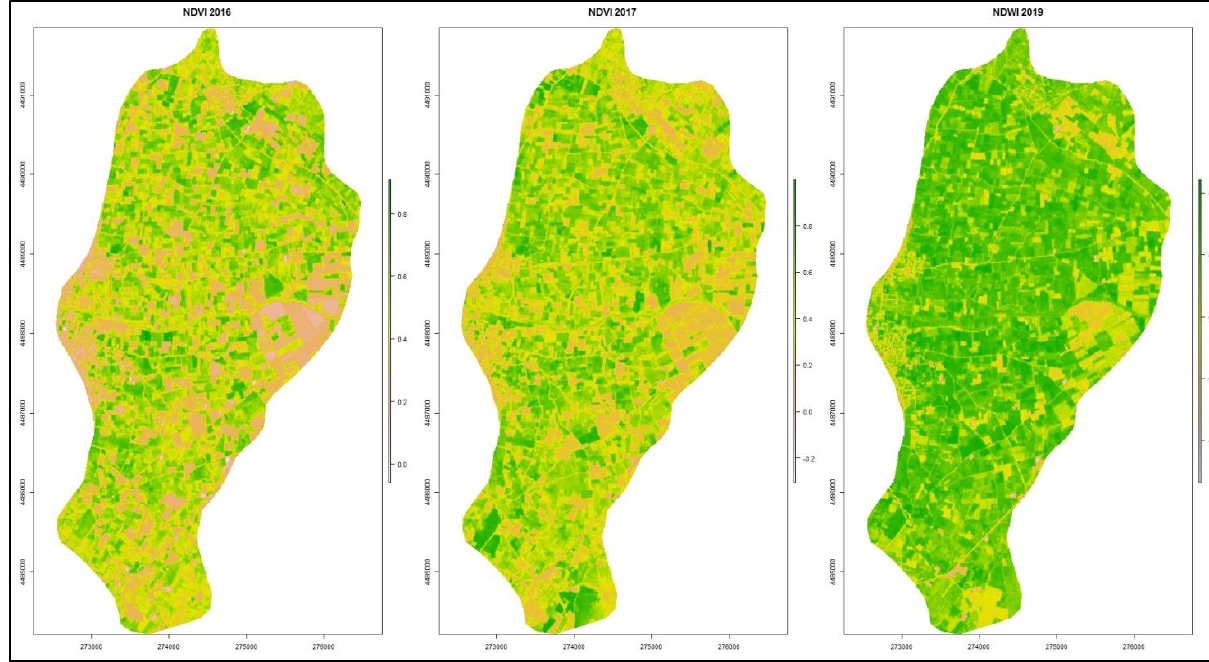
Figure 3. Satellite covariates of the study area.